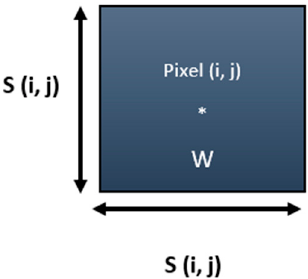
Figure 4. Adaptive mask used to detect the mouth area using depth information.